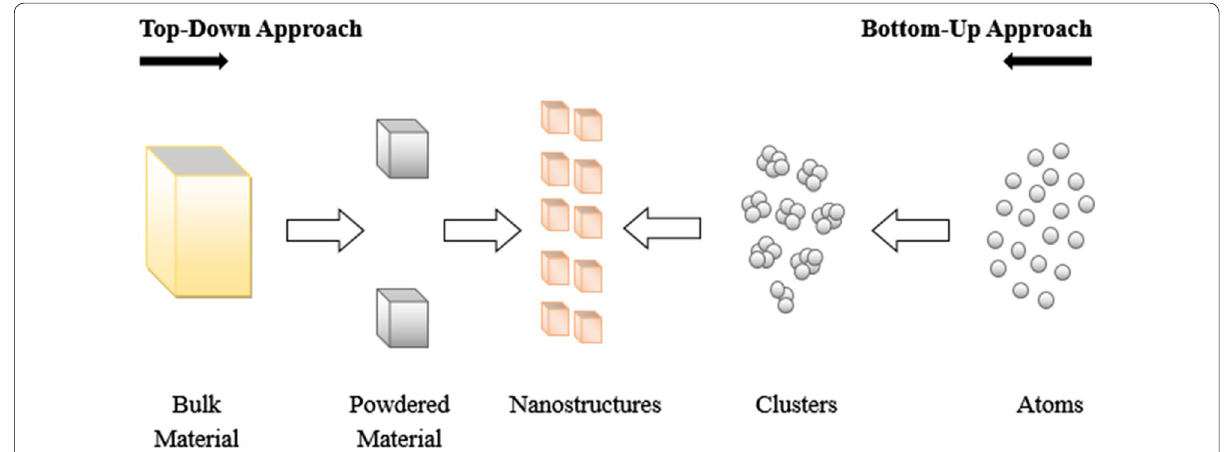
Fig. 1 Approaches for synthesis of nanostructures